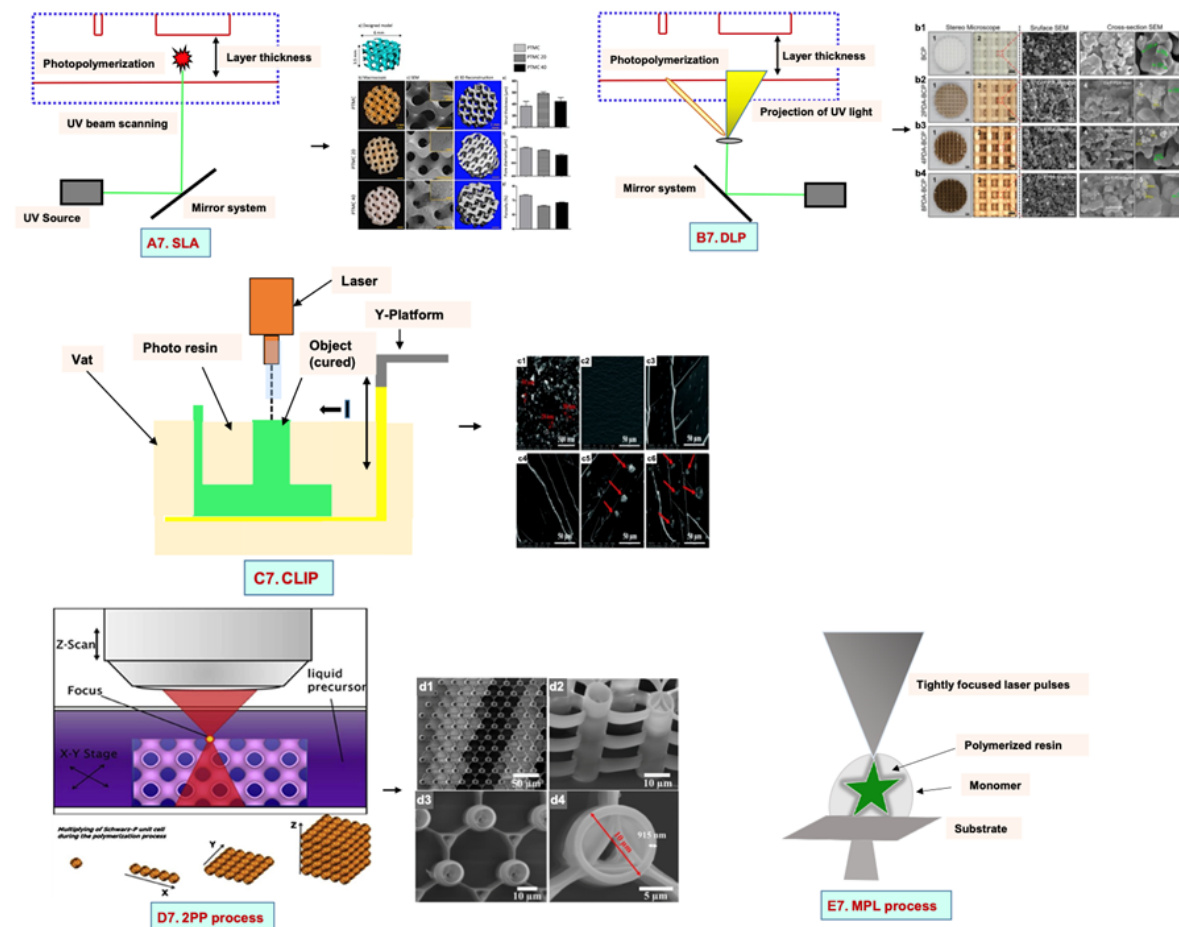
Figure 7. Mechanisms of various types of photolithography with microscopic images: ( A7 ) SLA. poly (trimethylene carbonate) microporous (PTMC) scaffolds with 20 and 40% of hydroxyapatite (HA) ( a ) Model design ( b ) macroscopic and ( c ) microscopic SEM images of all scaffolds ( d ) 3D architecture ( e ) strut thickness ( f ) pore diameter ( g ) porosity of all SLA fabricated scaffolds. Reprinted with permission from Ref. [141], Copyright 2022, Frontiers ( B7 ) DLP. Surface morphology, surface and cross ‐ sectional view of all scaffolds with PDA (polydopamine) modification dipped in Tris ‐ HCL at concentration of 2 mg/ml, 4 mg/ml and 8 mg/ml. ( b1 ) Biphasic calcium phosphate (BCP) ( b2 ) 2PDA ‐ BCP. ( b3 ) 4PDA ‐ BCP. ( b4 ) 8PDA ‐ BCP. Deposition of Ca ‐ P/PDA is showed by white stars, white arrows designate the PDA layer and amorphous Ca ‐ P nanoparticles. Green arrows illustrated by green arrows. the size of newly formed amorphous Ca ‐ P nanoparticles is showed by yellow circle. Reprinted with permission from Ref. [142], Copyright 2020, Frontiers (( A7 , B7 ) adapted from [143]), ( C7 ) CLIP. Reprinted with permission from Ref. [144], FE ‐ SEM images of ( c1 ) Pristine nHA and ( c2 – c6 ) Fractured surface of of poly(ethyleneglycol)diacrylate containing 0 wt%, 0.5 wt%, 1.0 wt%, 1.5 wt%, and 2.0 wt% n ‐ HA. Copyright 2021, RSC; Reprinted with permission from Ref. [145], Copyright 2018, IOPsceince ( D7 ) the 2PP process. ( d1 ) Large area over ‐ view ( d2 ) side ‐ view tilted at 30 °C ( d3 ) Top view and ( d4 ) closer top view of IP ‐ L780 photopolymer. Reprinted with permission from Ref. [146], Copyright 2008, Taylor & Francis; Reprinted with permission from Ref. [147], Copyright 2019, ACS and ( E7 ) the MPL process. Reprinted with permission from Ref. [148], Copyright 2008, Elsevier Ltd.